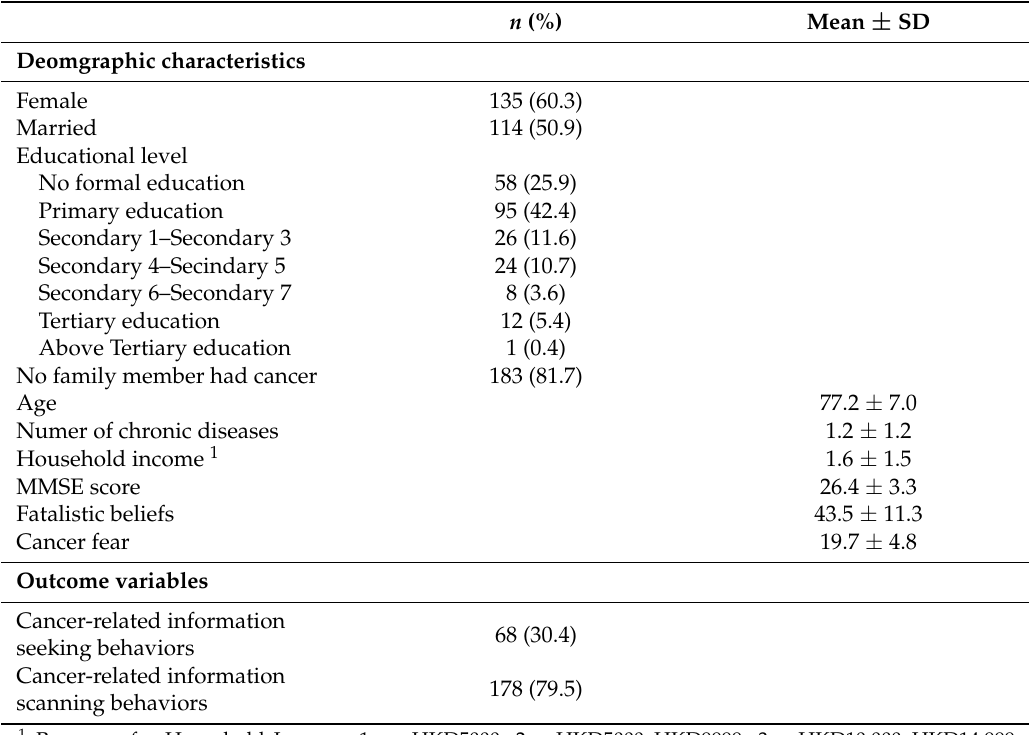
Table 1. Sample characteristics and proportions of cancer-related information seeking and scanning behaviors ( n =